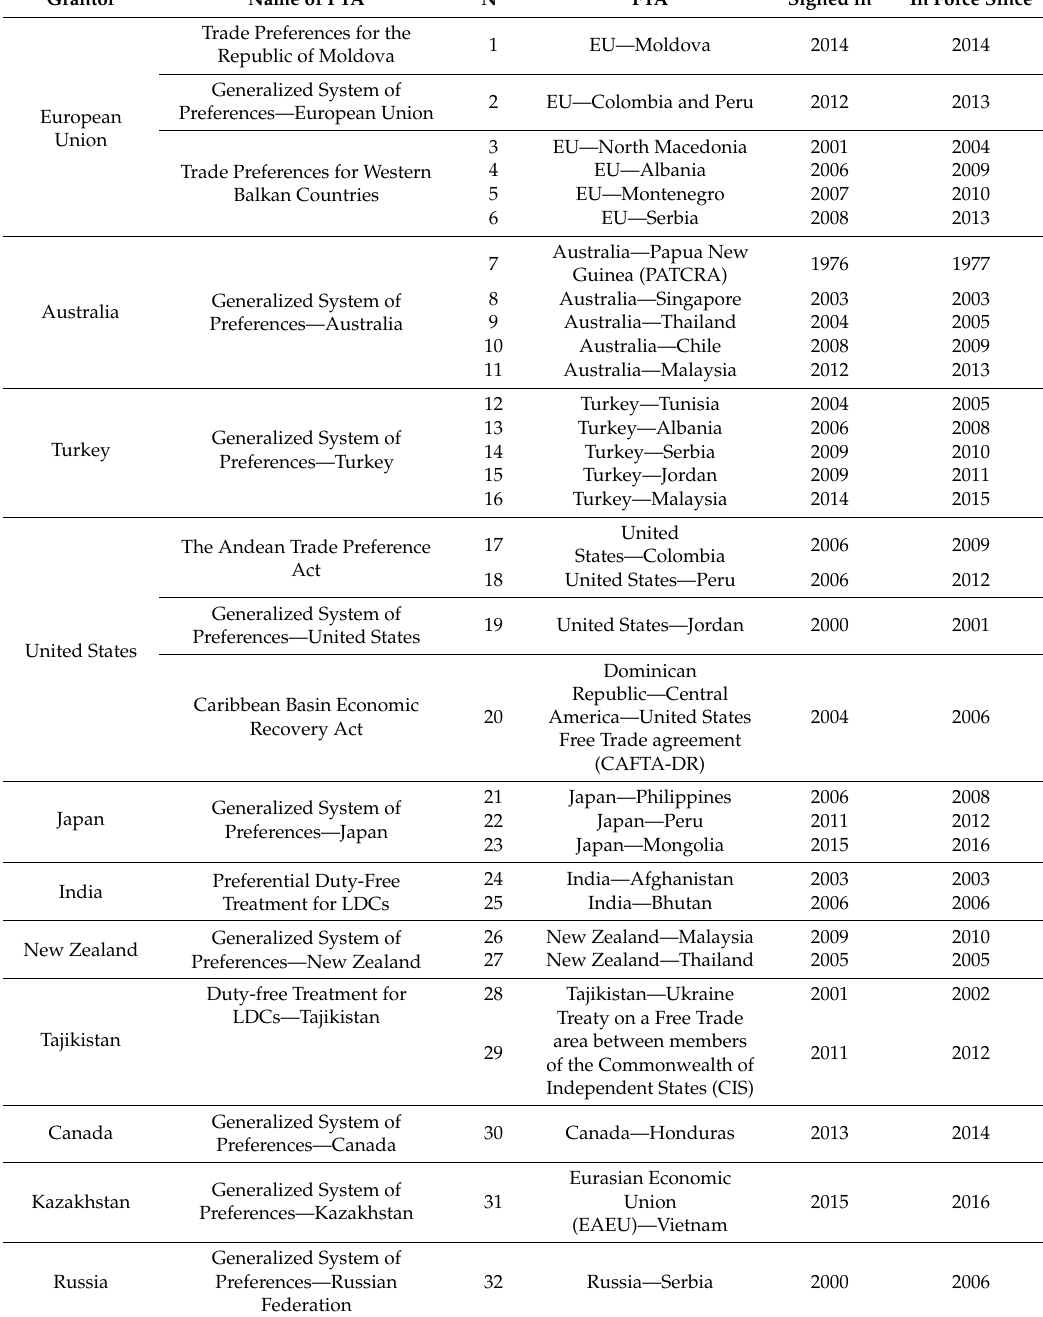
Table 5. List of PTAs resulting in the creation of